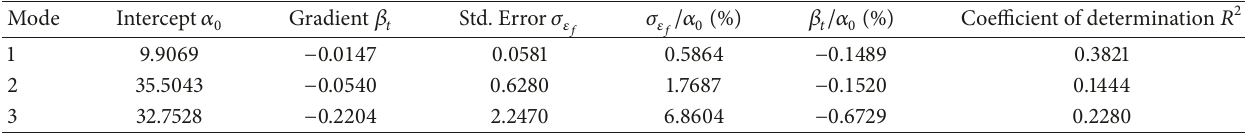
Table 3: Coefficients of linear regression model (frequency ∼ temperature) of girder No. 2.